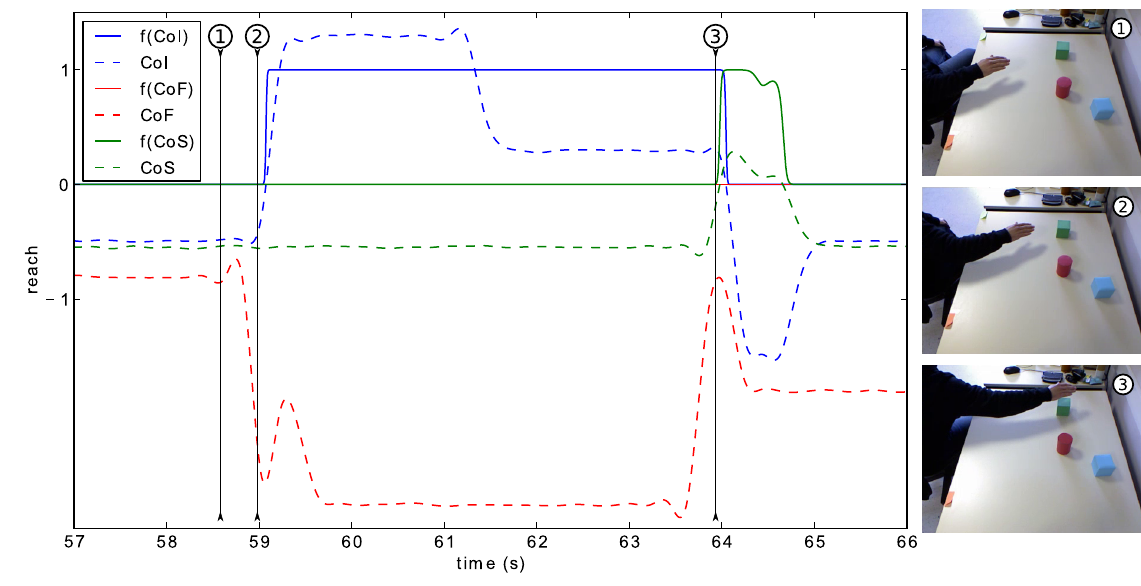
Figure 8: Detection of a successful reaching action: condition of satisfaction (CoS).